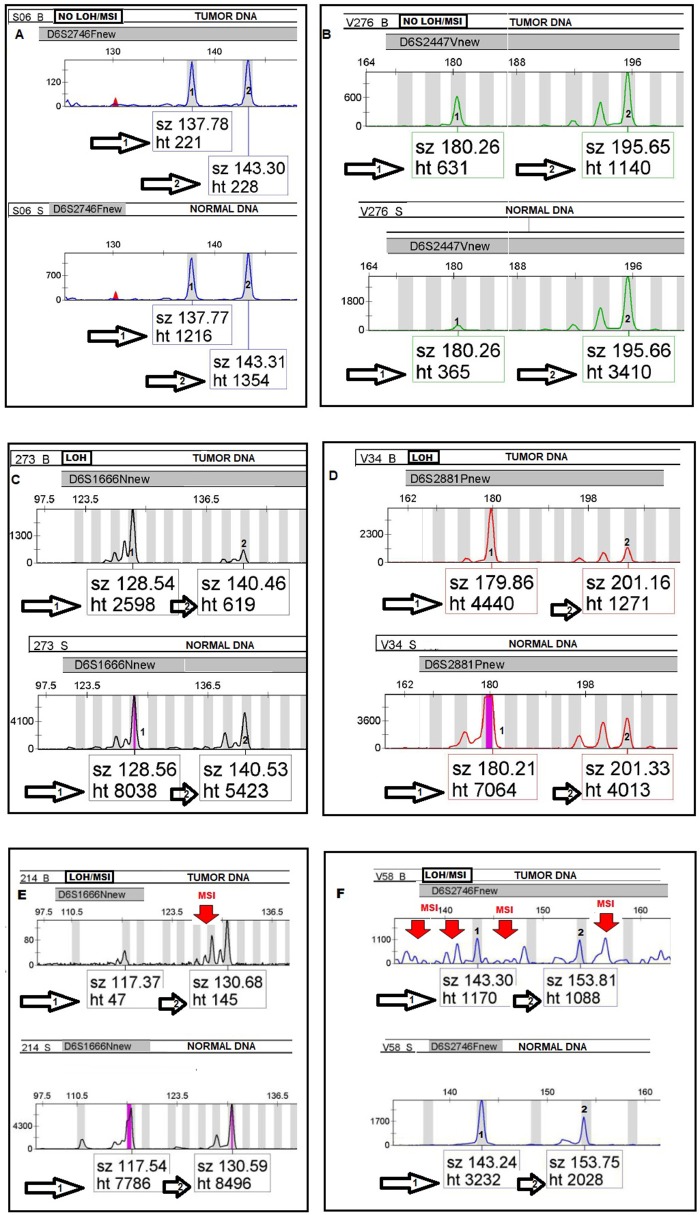
Electropherograms (A–F) illustrating the allelic status of tumor DNA compared to normal DNA in LOH/MSI analyses by using four fluorescently-labeled microsatellites markers. Paired tumor and normal heterozygous allele ratios were analyzed by allelic-imbalance factor by calculating the quotient of the peak ratios for each informative microsatellite alleles in the normal DNA divided by the corresponding ratio found in tumor DNA from the same patient as follows; Alleles in Normal 1:Normal 2/Tumor 1:Tumor 2.